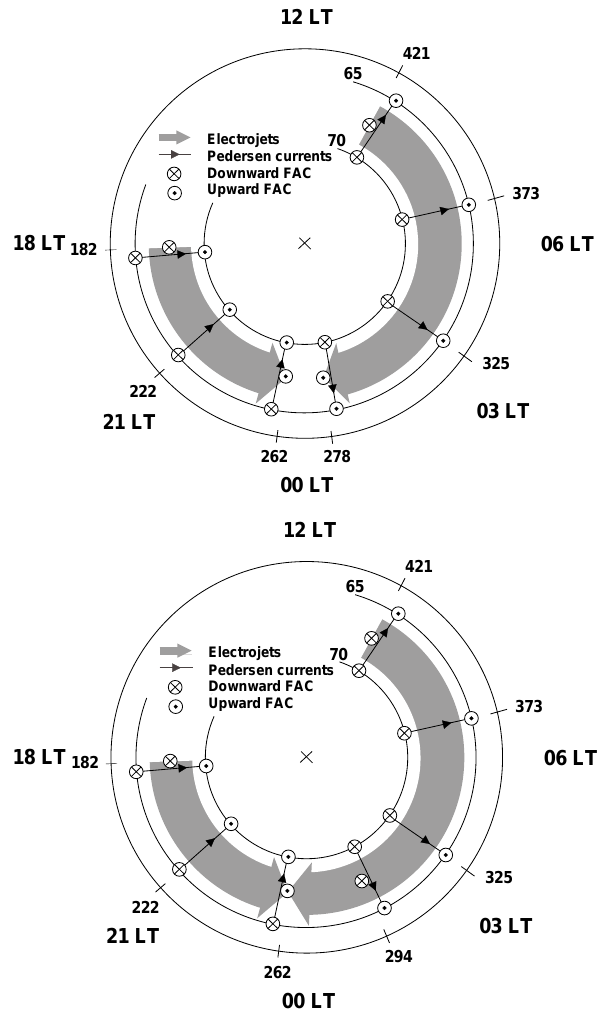
Fig. 4. (a) Schematic of the directly driven currents in the auro- ral oval between dawn and dusk, used in the model to describe the growth phase of a substorm just before the EP onset. (b) Same as Fig. 4a but for conditions just after substorm EP